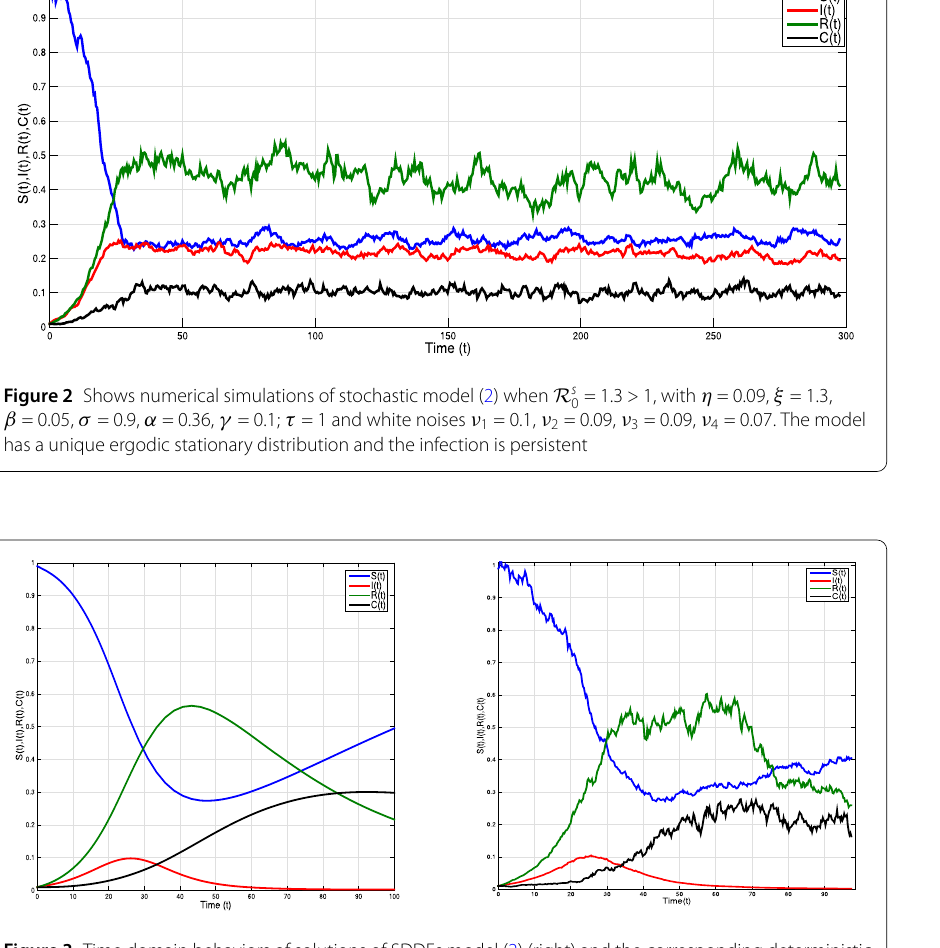
Figure 3 Time domain behaviors of solutions of SDDEs model (2) (right) and the corresponding deterministic model (1) (left) when R s 0 = 0.38 < 1, with η = 0.0005, ξ = 0.6, β = 0.01, σ = 0.12, α = 0.3, γ = 0.02; τ = 1.4 and white noises ν